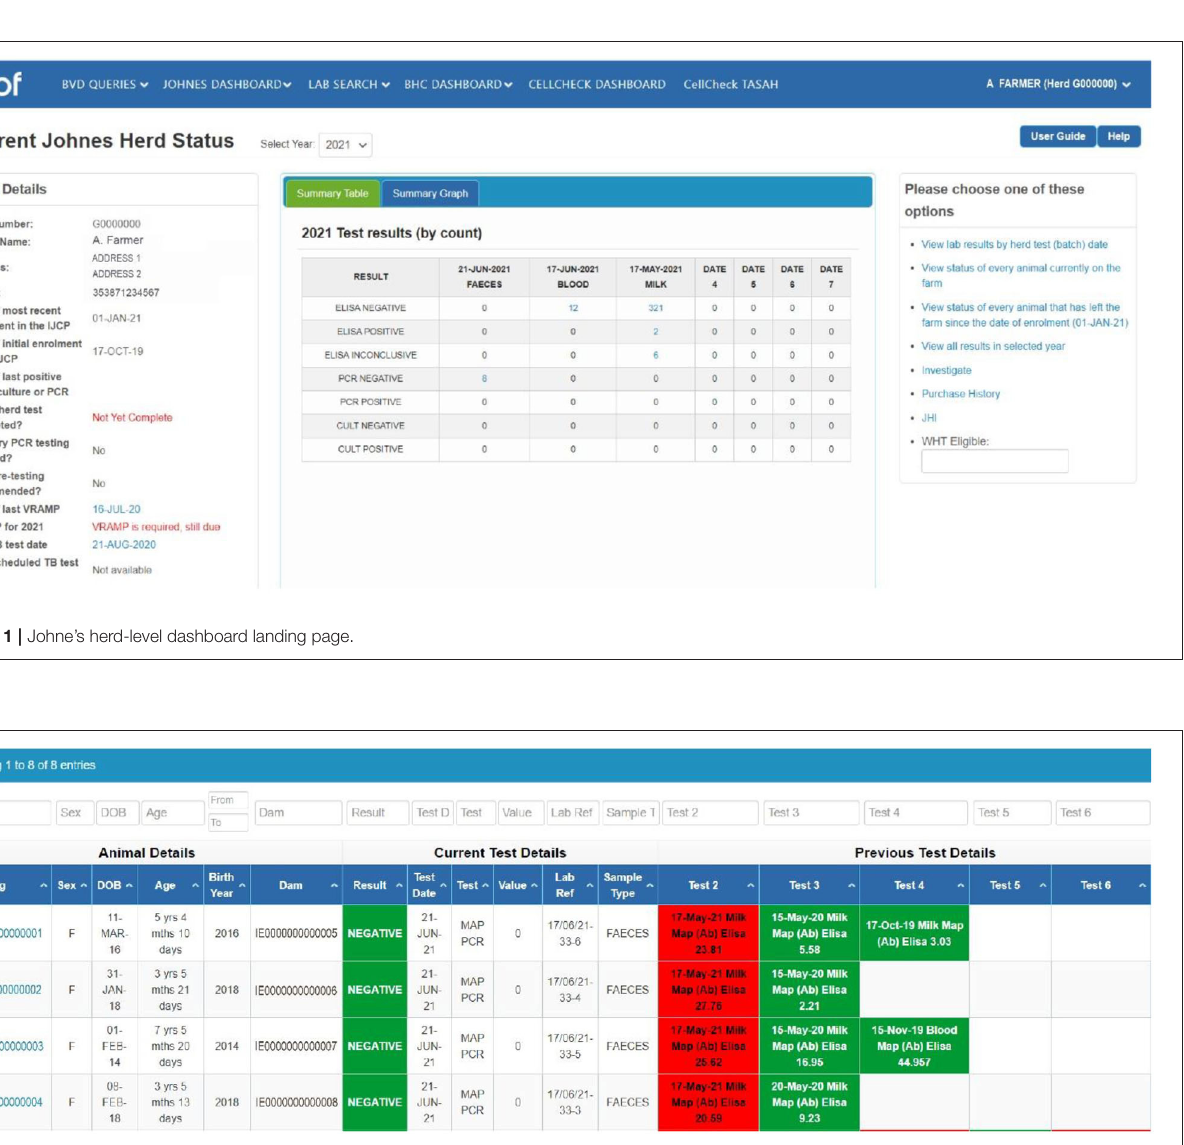
FIGURE 2 | ICBF display of listed